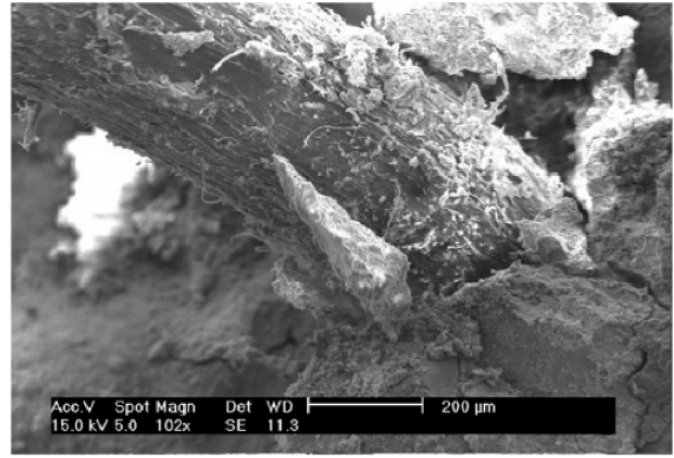
Figure 10. Poor bonding and entrapped air voids around a PE fibre in concrete matrix [131].